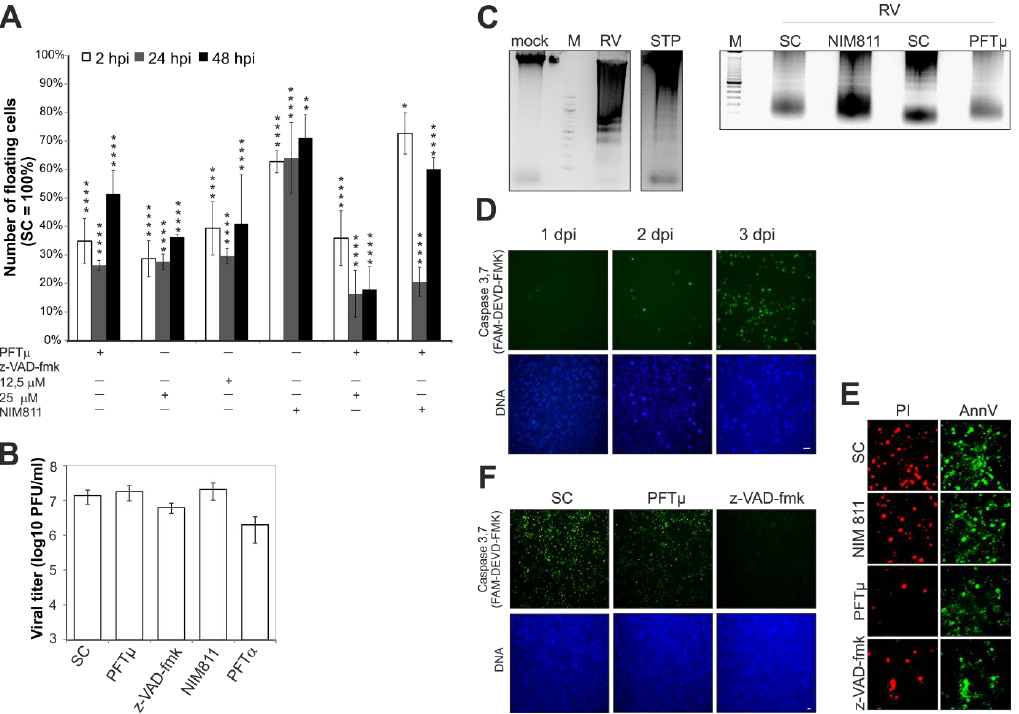
Figure 1. Analysis of selected pharmacological inhibitors (z-VAD-fmk (12.5 μM if not otherwise indicated), PFTμ and α (12 .5 μM), and NIM811 (2 μM)) with respect to RV replication and cytopathic indicated), PFT µ and α (12.5 µ M), and NIM811 (2 µ M)) with respect to RV replication and